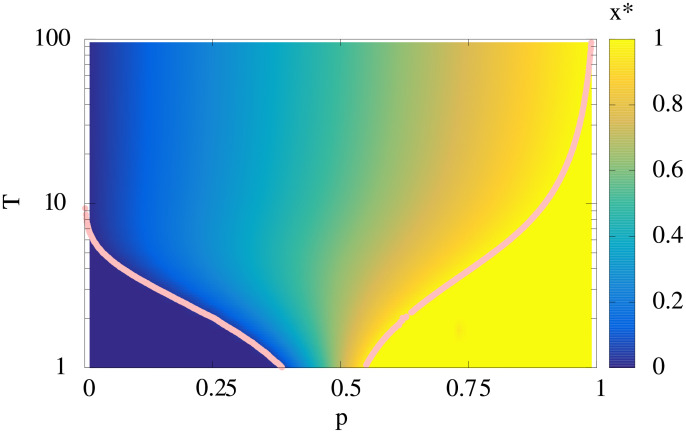
The phase diagram of the optimal fraction x*.The solid lines indicate the boundary between x* = 0 and x* > 0 (left region), x* = 1 (right region) and x* < 1. γ is set to unity.